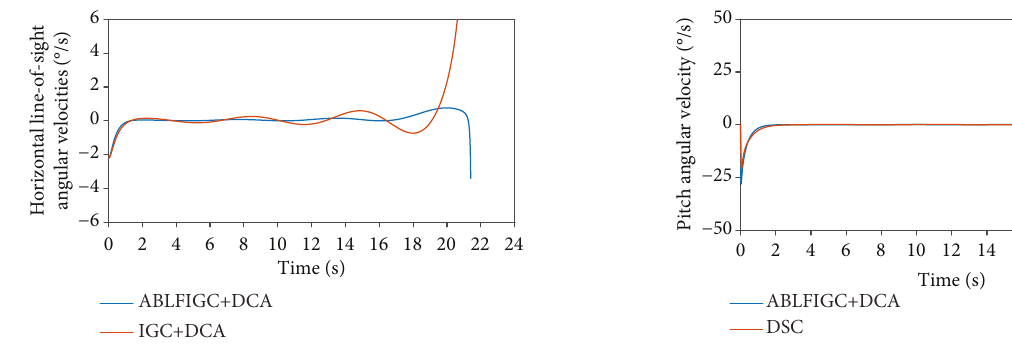
Figure 12: Pitch angular velocity curves of the interceptor missile in Scenario 2: ABLFIGC+DCA refers to a combination of the proposed asymmetric barrier Lyapunov function-based IGC algorithm and the dynamic control allocation algorithm; IGC+DCA refers to a combination of the IGC algorithm subject to the traditional dynamic surface sliding-mode control law and the dynamic control allocation algorithm.